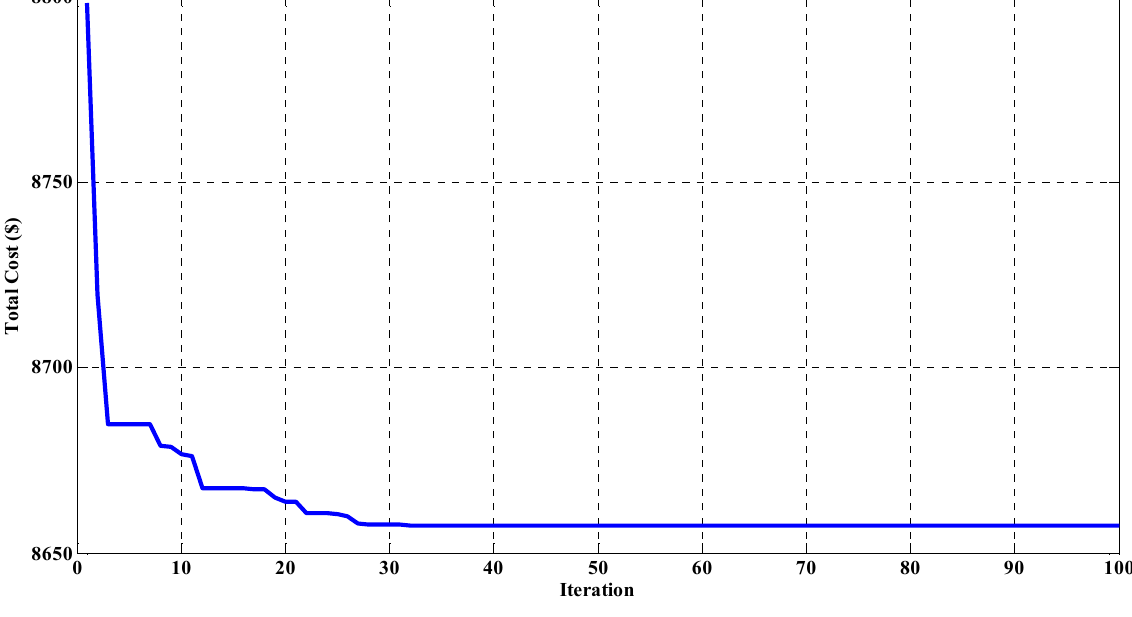
Figure 4. Convergence plot of FAMPSO for cost function without considering CHPH.